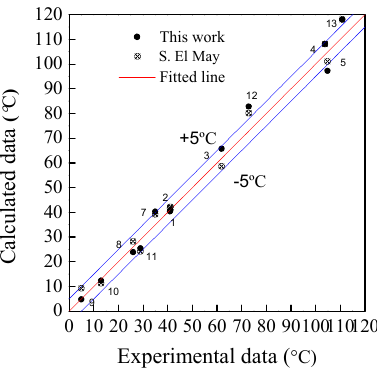
Figure 4. Data at different locations at the ambient temperature of 26 °C. Table 3. Calculated state points corresponding to specific streams.